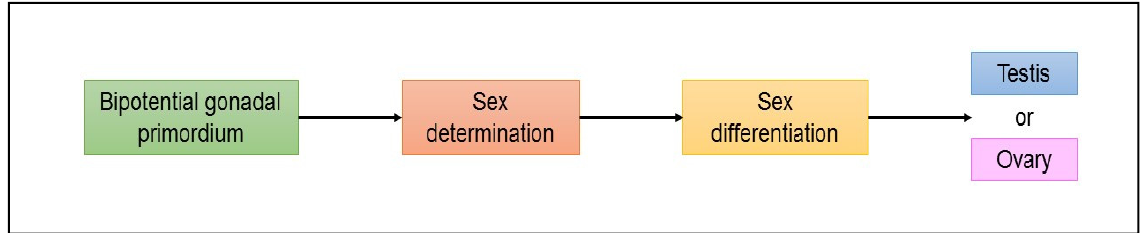
Figure 1. Basic pathway of gonadal development from bipotential gonadal primordium to become a testis or an ovary.